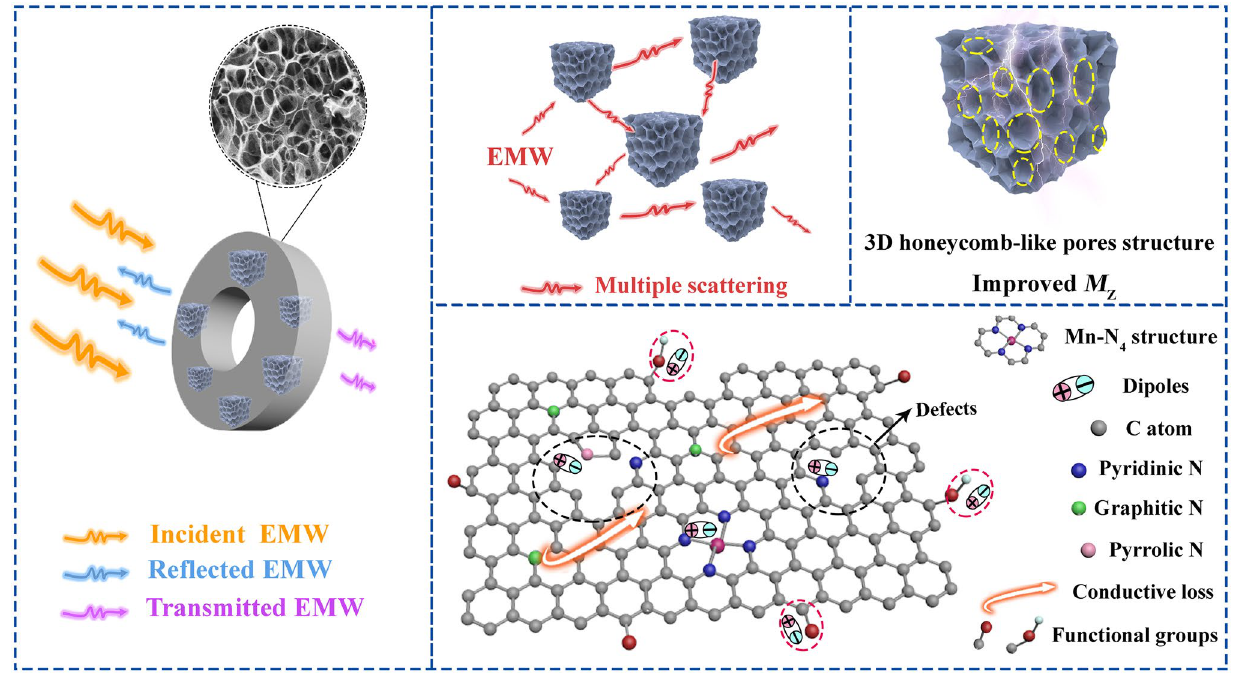
Fig. 8 Schematic illustration of the EMW absorption mechanism of 3D